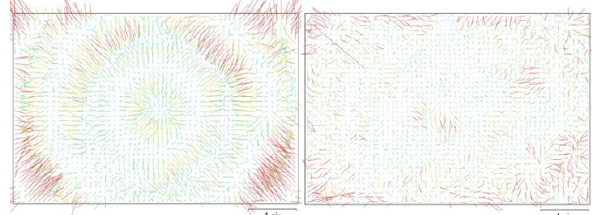
Figure 3. Residual plots from Agisoft Metashape with B and B+F96 for Canon D200 (data set 5); vector scale 1000.